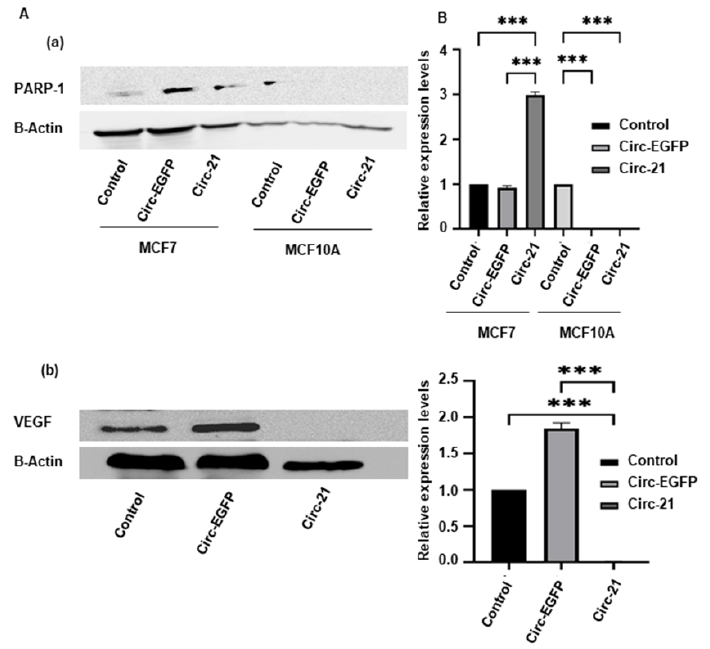
Figure 7. The Circ-21 actives PARP-1 ( a ) and decreases VEGF ( b ) expression in breast cancer cells. ( A ) A representative image of western blot analysis of PARP1 and VEGF. ( B ) A graphic representation of the densitometric analysis of PARP1 and VEGF. Relative expression levels represent PARP-1/beta-actin or VEGF/beta-actin ratios. Higher expression levels of PARP-1 in the Circ-21 MCF7 cells Circ-EGFP MCF7 cells and the control cells were detected. In contrast, no expression of VEGF was detected in the Circ-21 MCF7 cells. Values represent means ± SD ( n = 3). *** p < 0.001.